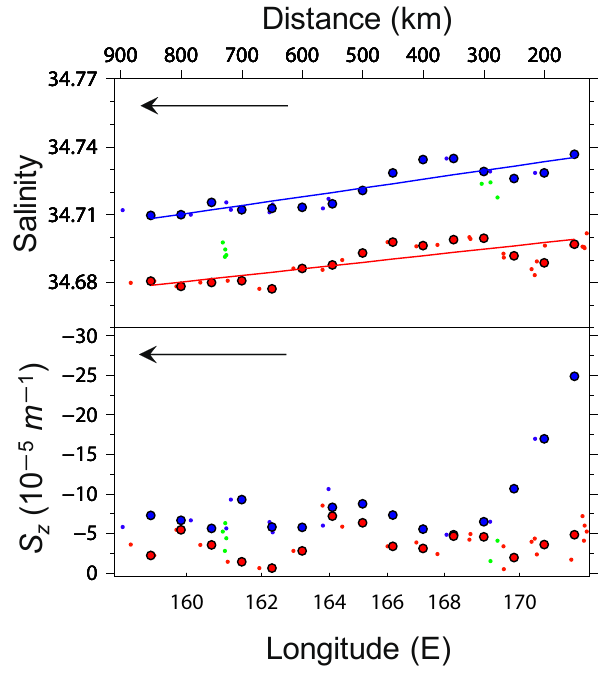
Fig. 9. Distribution of salinity averaged over the 100m-thick layer at the bottom (upper panel) and vertical salinity gradient (lower panel) along flow path of the RSBW. Small circles are from oc- cupations in the 1970s (blue), 1990s (green) and 2000s (red). In the estimation of vertical gradient, vertical gradients of 150m scale are calculated at every 1m interval by linear least square fit for each profile. The largest vertical gradients within 300m from bottom are adopted as vertical gradient formed between the RSBW and the am- bient water. Large circles are bin averages for the 1970s and 2000s and same colors as those for small circles are given. Solid lines in upper panel are regression lines for bin averages in region between 150km and 900km downstream from the Drygalski Trough. Ar- rows in both panels indicate downstream direction of